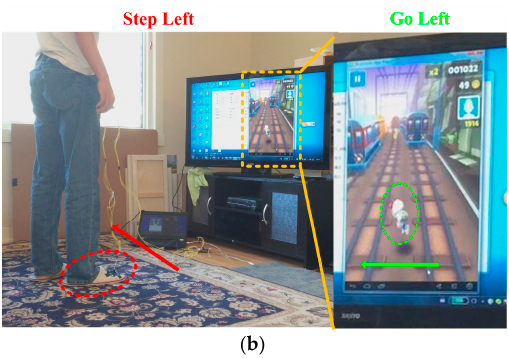
Figure 15 Practical game play test in Game Subway Surfers: ( a ) Step forward; and ( b ) Step left.